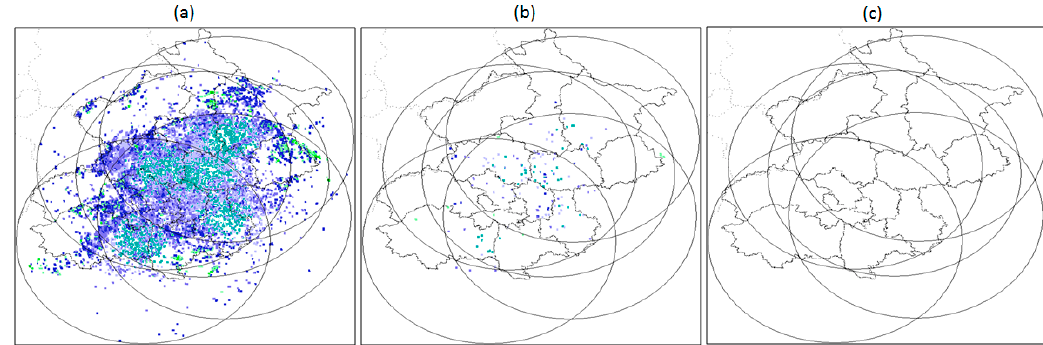
Figure 11. ( a ) CAT echoes from the five radars, the ( b ) CAT-removed echoes using the Bayesian method, and ( c ) the isolated echo filtered after Bayesian method. Table 2. The effect of CAT echo recognition and elimination.